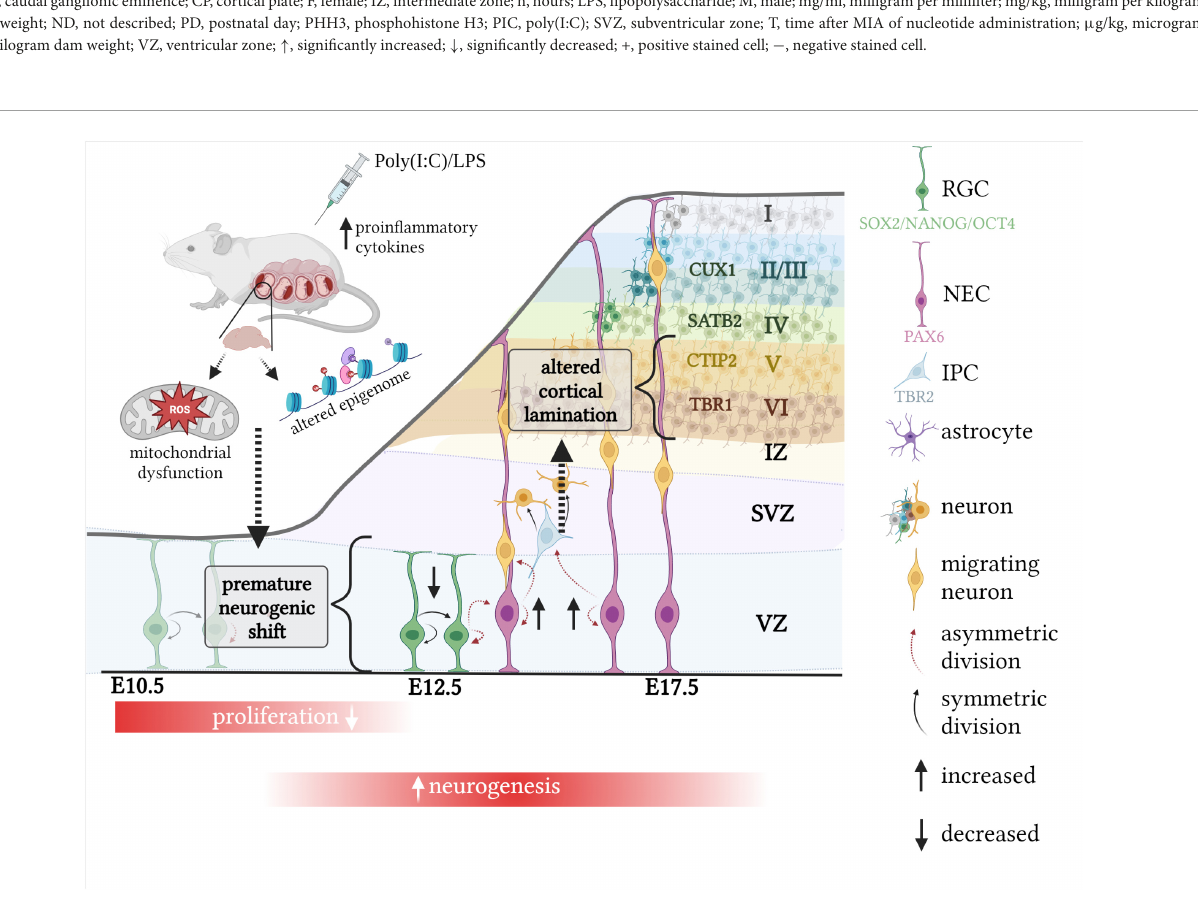
FIGURE2 The impact of MIA on murine corticogenesis. Exposure to MIA whilst in utero causes an acute neurogenesis defect, associated with a decreased proportion of symmetric, proliferative divisions and increased number of asymmetric, neurogenic divisions. This results in cortical lamination defects which are dependent on the timing of MIA exposure. When induced at E12.5, increased neuron production at the expense of proliferation is associated with altered density of earlier born cortical layers, such as VI and V, which are defined by the transcription factors TBR1 and CTIP2, respectively. Mitochondrial dysfunction as well as an altered epigenome may explain the acute neurogenesis defect following MIA. Created with